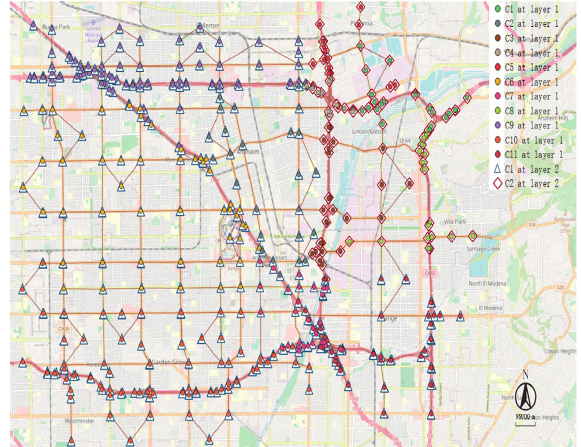
Figure 13: Communities and hierarchies of the Anaheim network plotted by